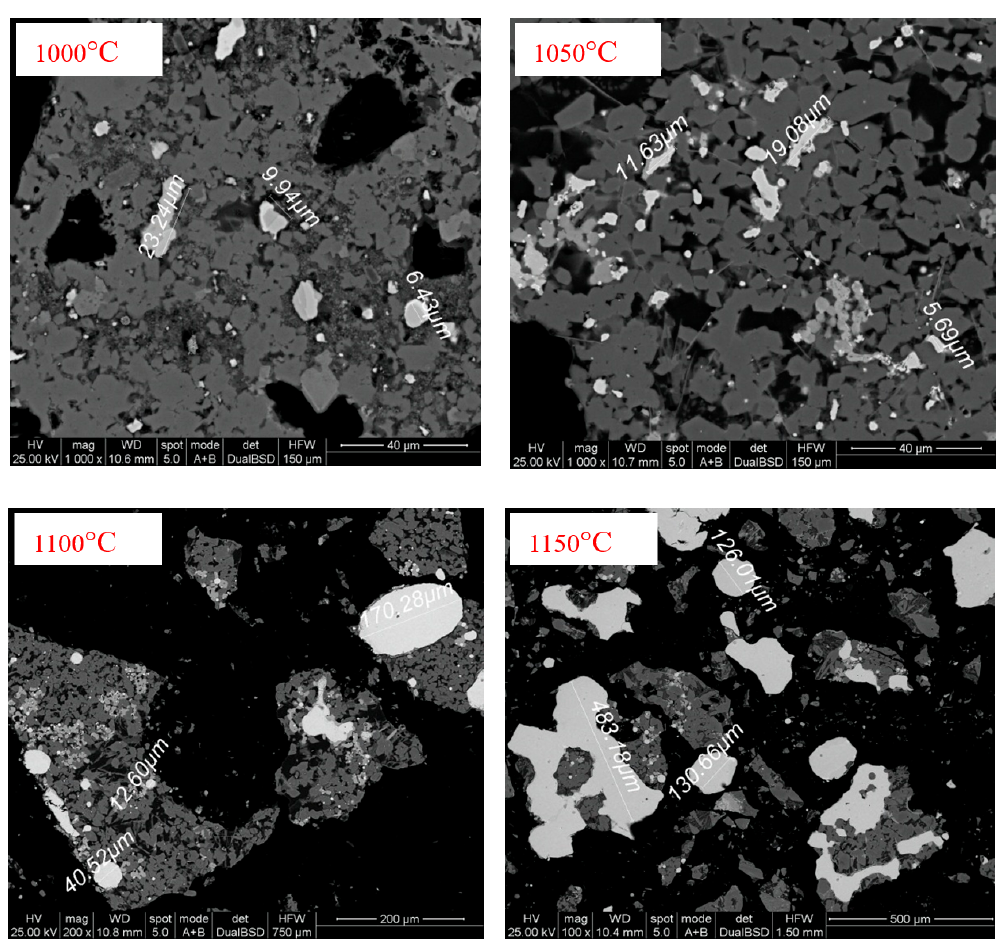
Figure 12. SEM image of the reduction calcines at 1000 °C, 1050 °C, 1100 °C, and 1150 °C.